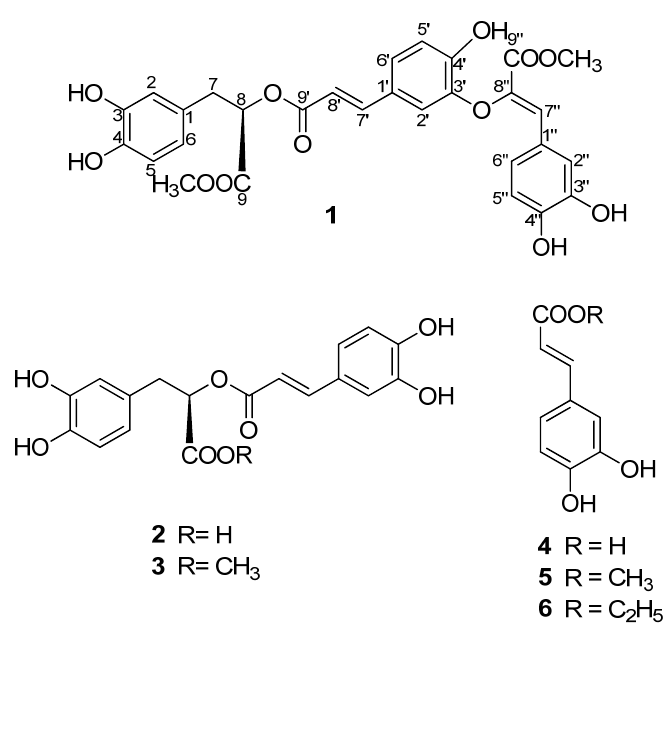
Figure 2. Structures of compounds 1 – 6